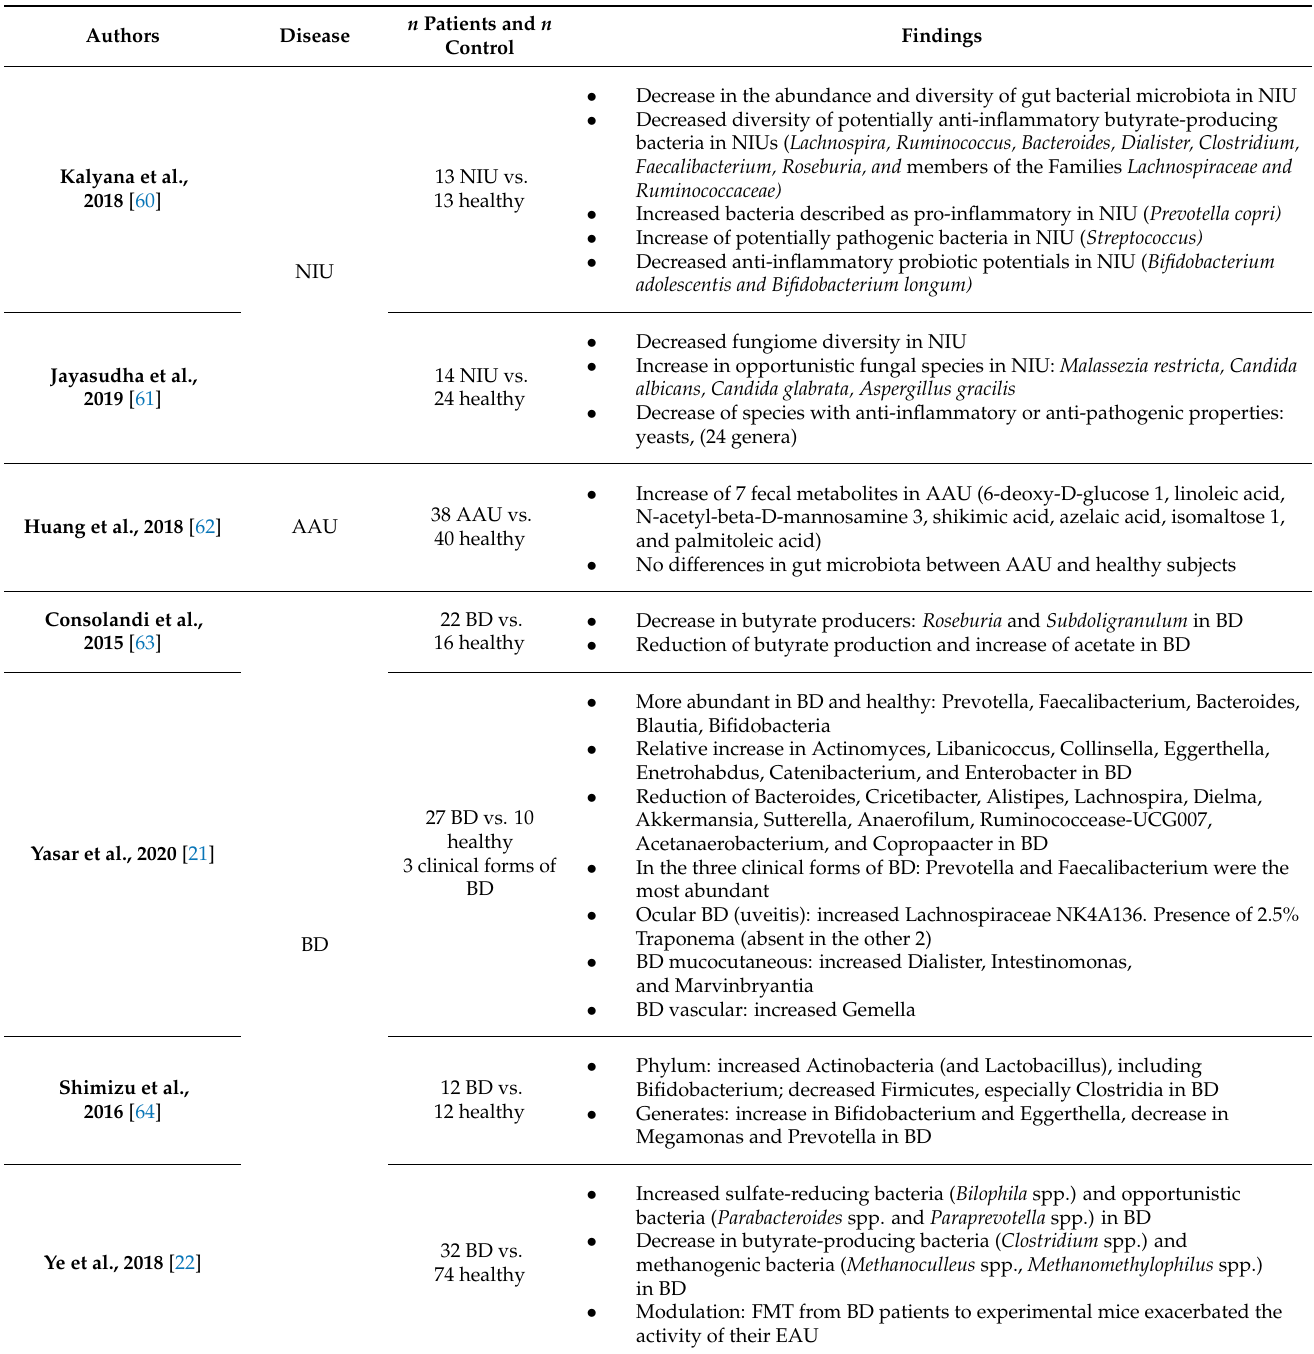
Table 2. Clinical studies in which the causality of NIU has been related to the microbiota, and different therapeutic strategies for its